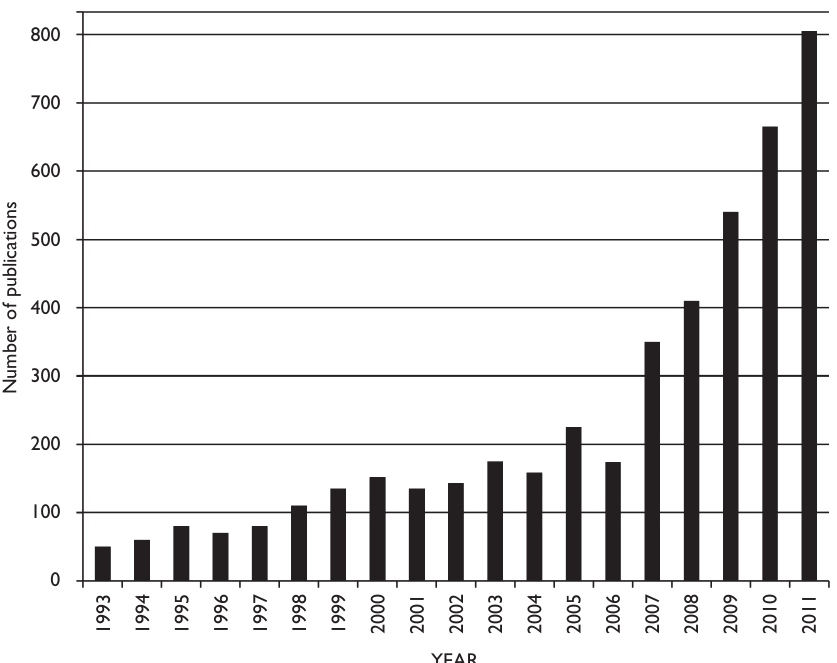
Figure 1. Increase in the number of publications in the field of biodiversity and nature conservation, cre- ated from the Web of Science using the string: Title = „biodiversity“ OR „nature conservation“ OR Topic =“biodiversity“ OR „nature